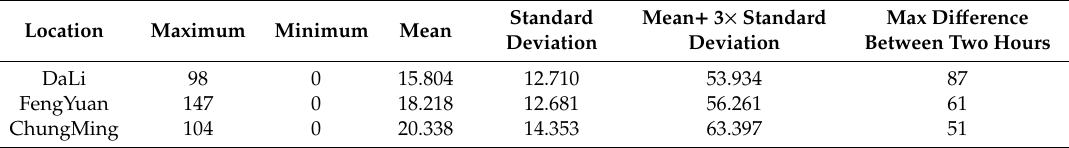
Figure 5. One whole year of particulate matter 2.5 (PM2.5) data from three target locations in 2018: ( a ) DaLi; ( b ) FengYuan; ( c ) ChungMing. Table 2. Description of datasets and statistical results pertaining to the three locations discussed in this